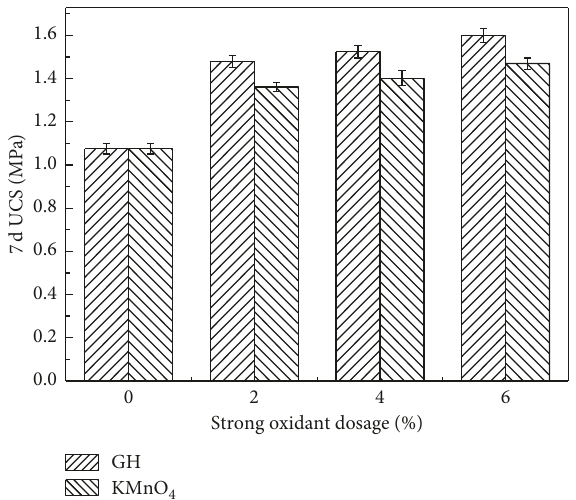
Figure 1: Unconfined compressive strength of samples added with different dosages of strong oxidant (7d).